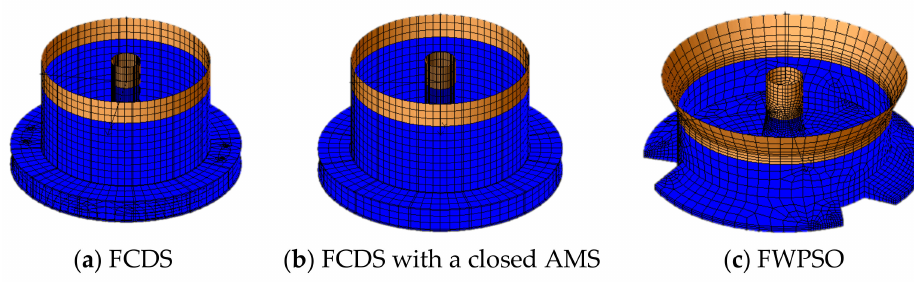
Figure 4. Panel models of the FCDS and